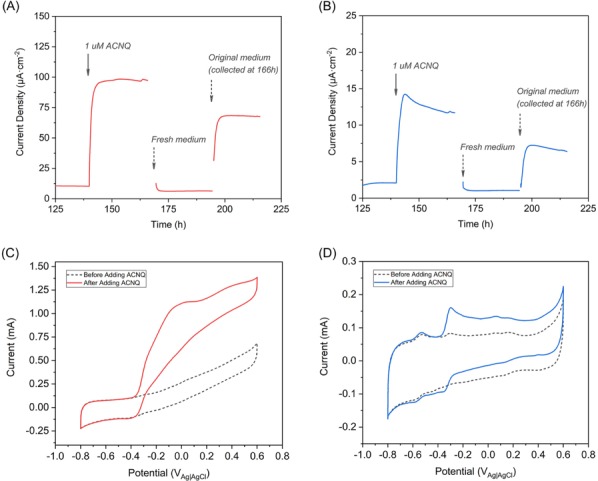
ACNQ acts as an extracellular electron transfer mediator for S. oneidensis Δbfe and Δmtr.(A) Chronoamperometry of S. oneidensis Δbfe. (B) Chronoamperometry of S. oneidensis Δmtr. (C) CV scan of the S. oneidensis Δbfe. (D) CV scan of the S. oneidensis Δmtr.